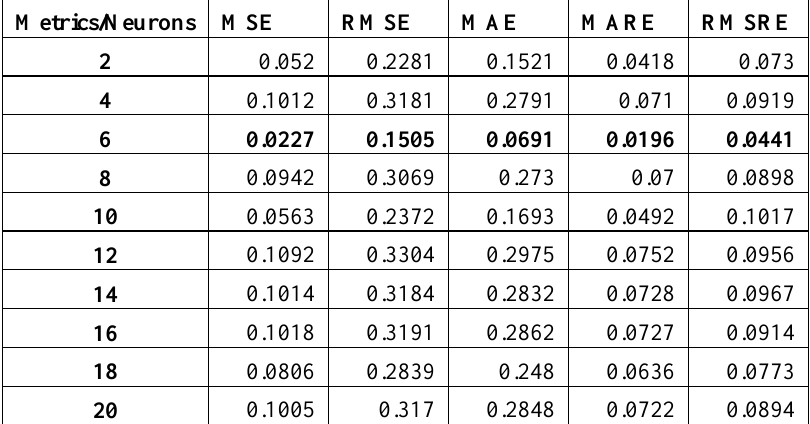
Table.2 Performance Error Metrics resulted by MLP